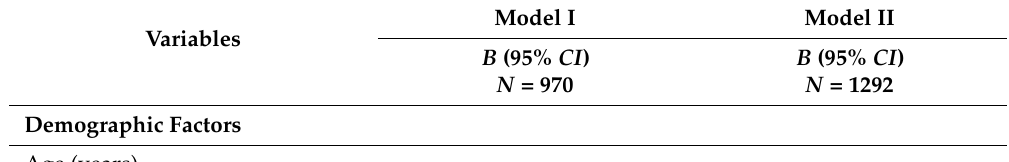
Table 4. Summary of multiple regressions for TV-watching